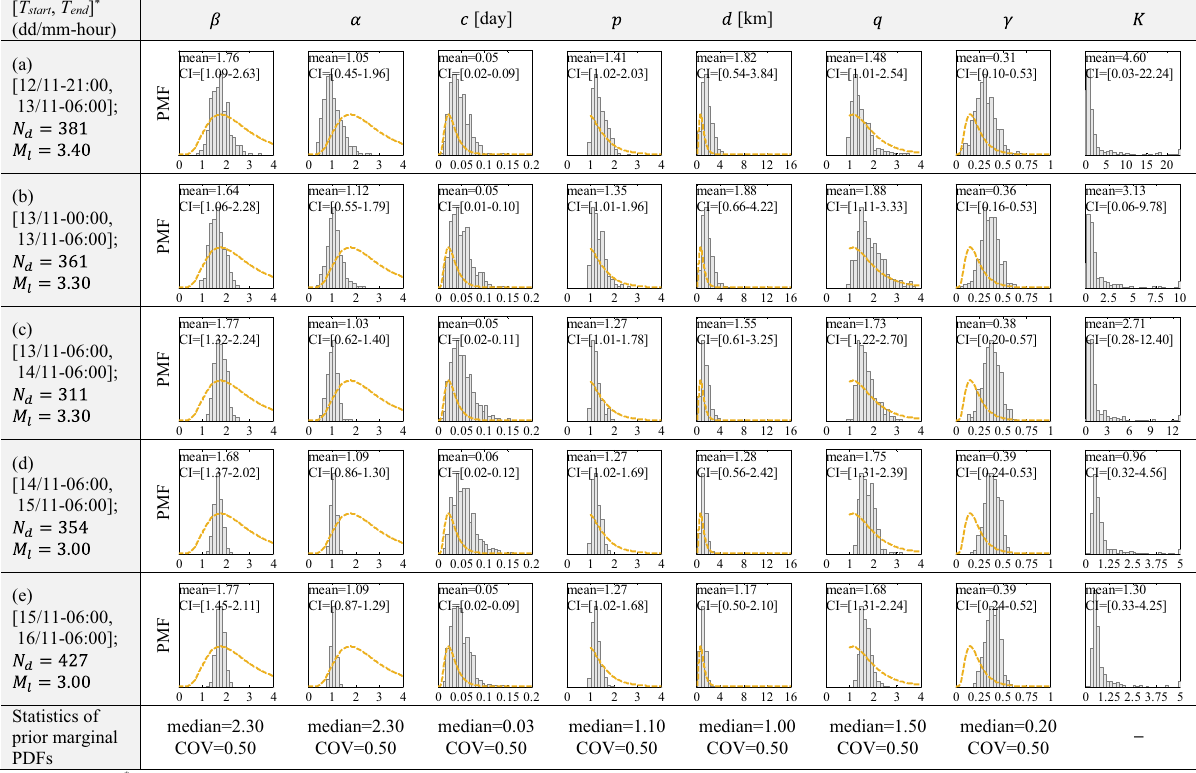
PDFs (illustrated with dashed-orange lines); in addition, the histogram of parameter K derived based on Eq. (17) is shown in the last column. The statistics of the samples including mean and [2%-98%] confidence interval (CI) of the posterior of model parameters { θ = [ β , α , c , p , d , q , γ ], K } are also shown on the corresponding marginal distribution in Table 1. The last row of Table 1 reports the statistics for the prior marginal PDFs of θ . To capture the outliers of K , we have set the upper limit of the horizontal axis to be around 98th percentile of K . Since all ETAS parameters are positive, we assigned a multivariate lognormal distribution as prior to the model param- eters θ (see Eq. 19; zero correlations are considered at the prior level) with a coefficient of variation (COV) equal to 0.5 for all the parameters (high COV is assumed to avoid using an over-informative prior distribution). The ln10 2.3026 . This selection was done deliberately to allow prior median values for both β and α are set to 1.0 × = the Bayesian updating algorithm to infer these two parameters. It can be observed in Table 1 that α < β holds